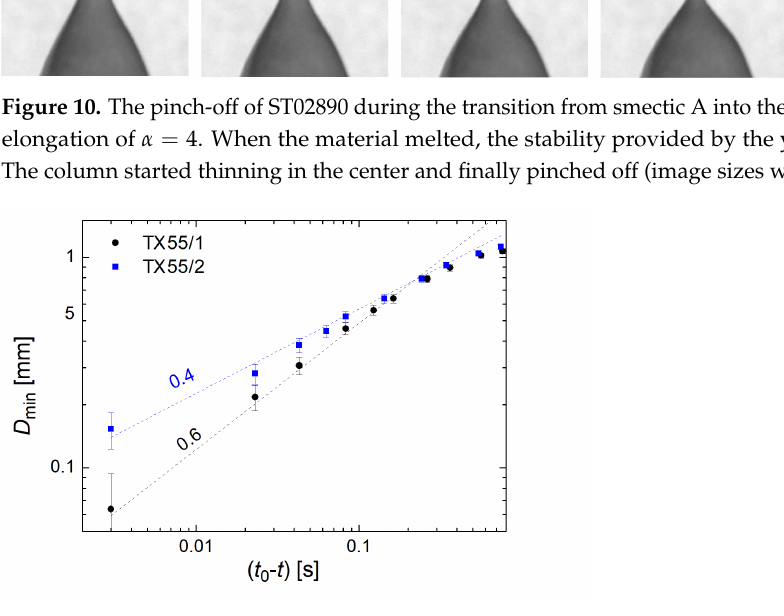
Figure 11. The pinch-off of ST02890 during the transition from smectic A into the nematic phase: Thinning of the neck diameter D min as a function of time to pinch-off at t 0 . The dashed lines mark ( t − t ) γ for the given exponents. Evidently, both graphs yielded qualitatively different γ values, 0 even though the experimental conditions were the